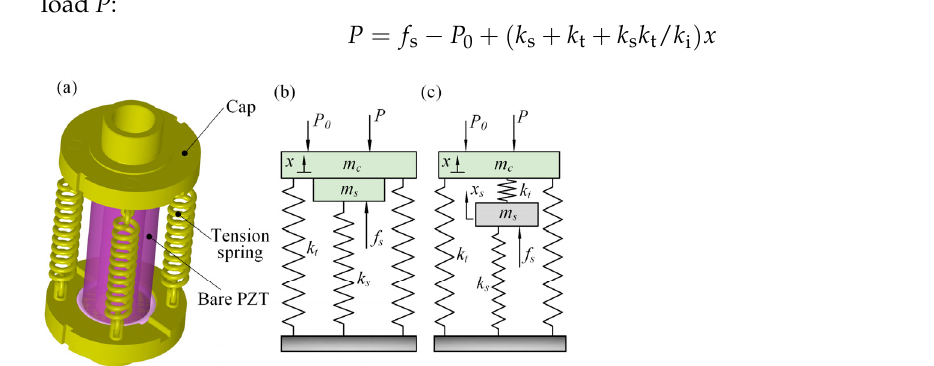
Figure 6. PZT stack’s performance. ( a ) Load versus displacement; ( b ) equivalent stiffness versus load; ( c ) displacement versus drive frequency. 3.2. Model of the Clamping Mechanism The screw–nut clamping unit could be usually simulated by a plane wedge block, as shown in Figure 4, where the wedge angle was equal to the screw pitch angle and the nut mass was calculated by the ratio of its inertia to the square of its radius. For simplicity, the equivalent stiffness for a homogeneous bar or tube ‐ shaped structure, such as the feed screw and actuator’s housing discussed below, was reckoned by a ratio of the product of its material’s Young modulus and sectional area to the effective length while the structural damping for the actuator’s components was determined based on their material loss fac ‐ tors. In addition, as a significant part influencing the model’s accuracy and time cost di ‐ rectly, the screw–nut interface model that characterizes the discontinuous high ‐ force con ‐ tact and friction behavior should be treated with discretion here. The most convenient approach for modeling the contact of the rough surfaces is the probabilistic method, which begins with the study of a single asperity’s behavior on a microscopic scale and then in ‐ corporates it in a statistical model of multiple asperity contact [19]. There have been many typical asperity contact models considering the different deformation processes published so far, such as the Hertz, CEB, ZMC, KE, JG model, and so on [20–23]. However, the purely elastic Hertz model proposed by Greenwood seems suitable for long ‐ term intermittent contact in this study, whereupon the contact load is given: 𝑃 (cid:3032) (cid:3404) 4 𝐸 (cid:3400) 𝑅 (cid:2869) (cid:2870) 𝑊 (cid:2871) (cid:2870) /3